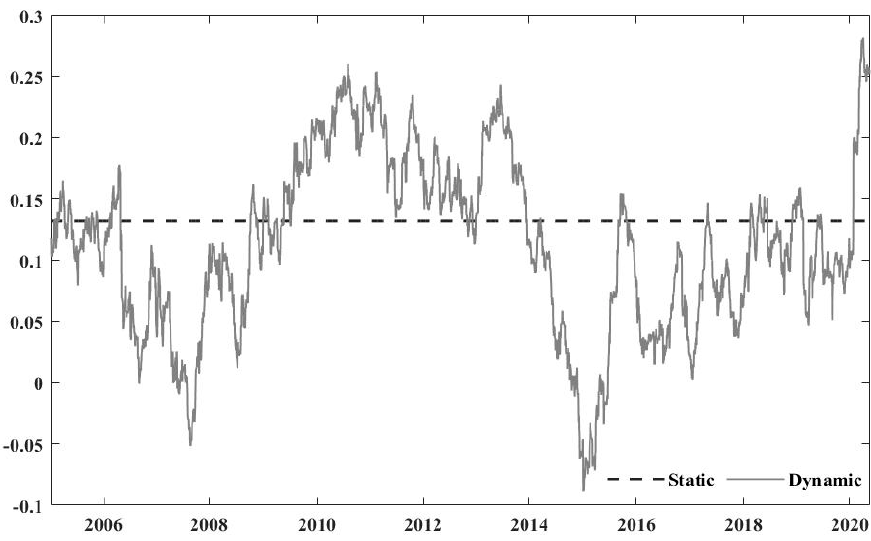
Figure 8. Tail correlation between the Brent spot price and the yield of CSI-energy.